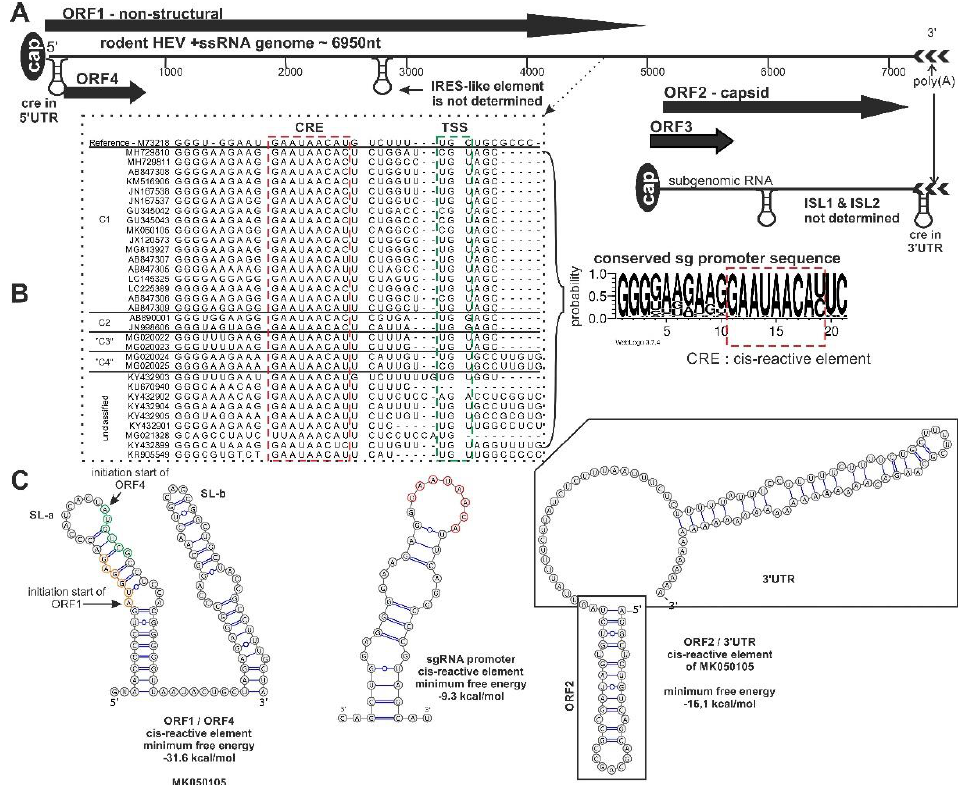
Figure 1. Schematic genome organization of rodent origin hepeviruses in species Orthohepevirus C and closely related, unassigned rodent hepeviruses. ( A ) The genome representation, ( B ) the significant nucleotide signals, and ( C ) the prediction of secondary RNA structural elements in rodent hepeviruses are presented. The alignment of the subgenomic RNA promoter sequence region (black dotted line), including the cis-reactive site (CRE) (red dotted line) and the transcription initiation site (TSS) (green dotted line), are highlighted. The consensus nucleotide Logo is generated from the alignment [49]. The internal ribosome entry site (IRES)-like, internal stem-loop (ISL)1/ISL2, CRE secondary RNA structural elements were predicted by ViennaRNA Web Service using the RNAfold server [50]. Open reading frame (ORF)4 is not present in all members of the orthohepevirus C. Four main polyproteins are translated from the open reading frames (ORFs) of HEV (Figure 2).